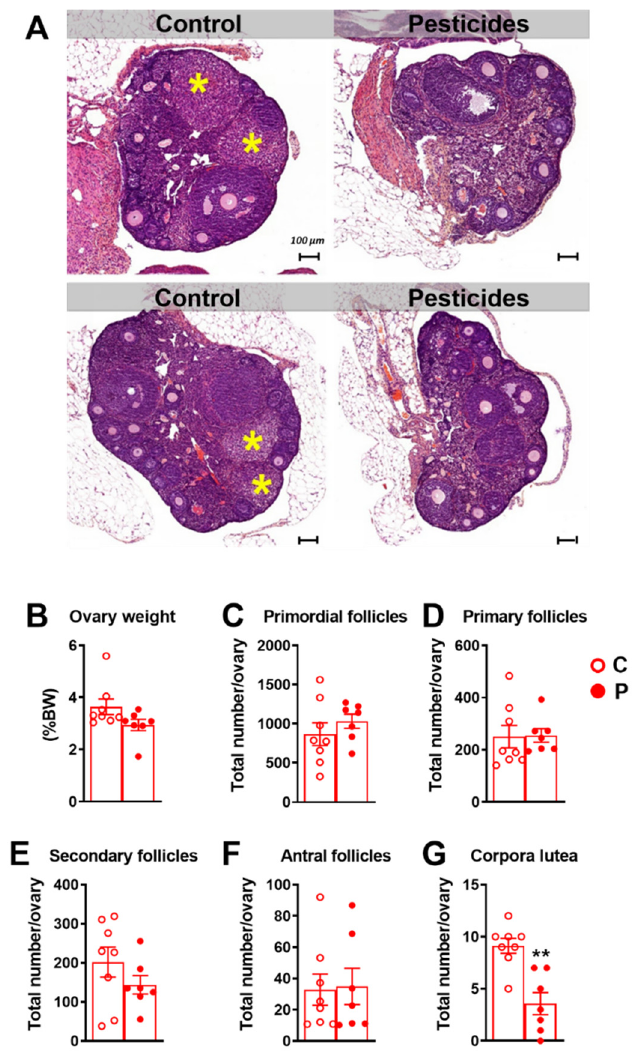
Figure 4. ( A ) Hemalun-eosin staining of murine ovary sections in control and pesticide-exposed female offspring. * in yellow indicates corpus luteum. Ovaries from pesticide-exposed female offspring presented with a disorganised structure and atrophy of the entire ovarian stroma, as well as fewer corpora lutea. ( B ) Ovary weight; ( C ) primordial, ( D ) primary, ( E ) secondary, ( F ) and antral follicles; and ( G ) corpora lutea number in seven pesticide-exposed and eight unexposed female offspring. Data are presented as mean ± SEM. ** p < 0.005 for P vs. C. We counted the follicles in five sections per ovary and estimated the total number of follicles per ovary at different stages according to a stereological method (cf. Section